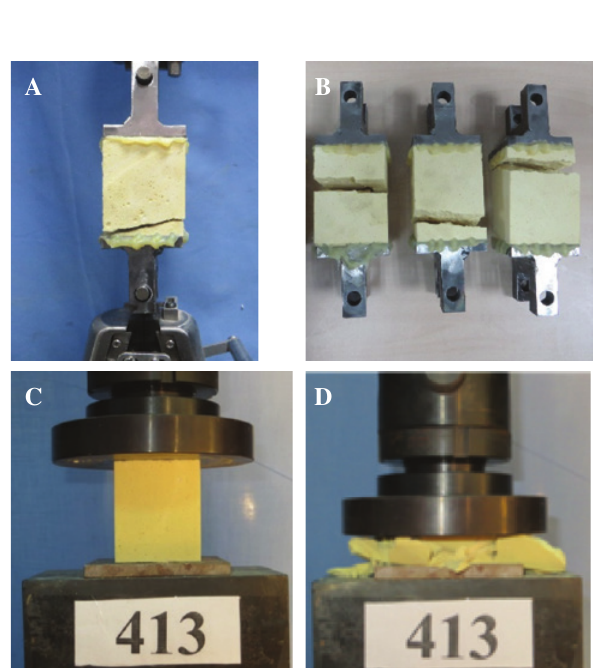
Figure 3: Foam core tests (A) test set-up for tensile test, (B) tensile failure, (C) test set-up for compressive test, (D) compressive